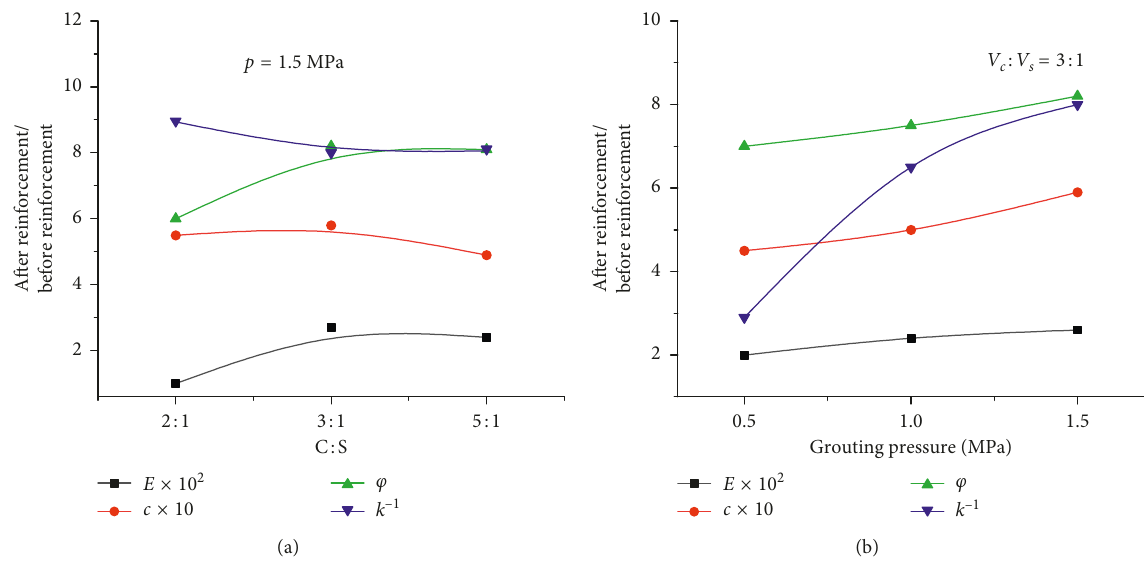
Figure 4: Relationship between performances before and after grouting reinforcement under different slurry ratio and grouting pressure.